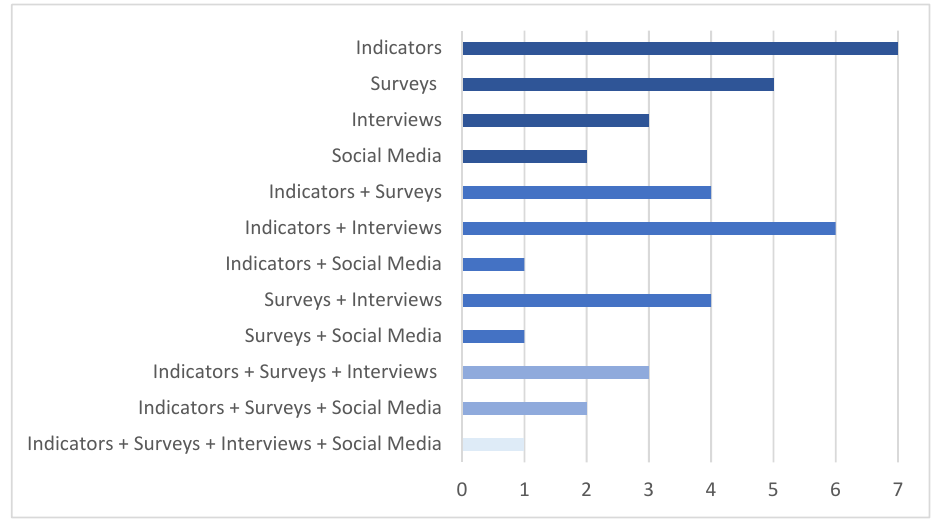
Figure 2. Overtourism measurement tools in literature.